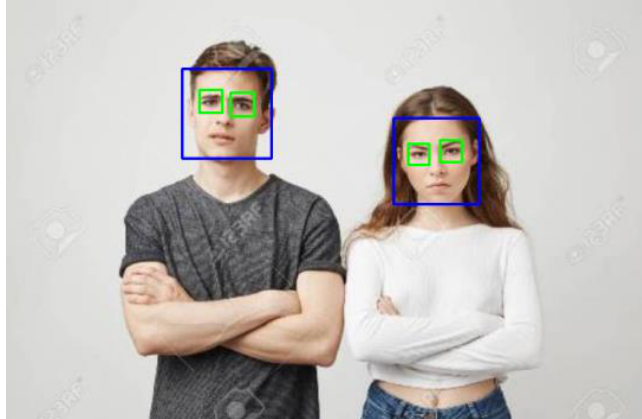
Figure 30. Considering the double face object.